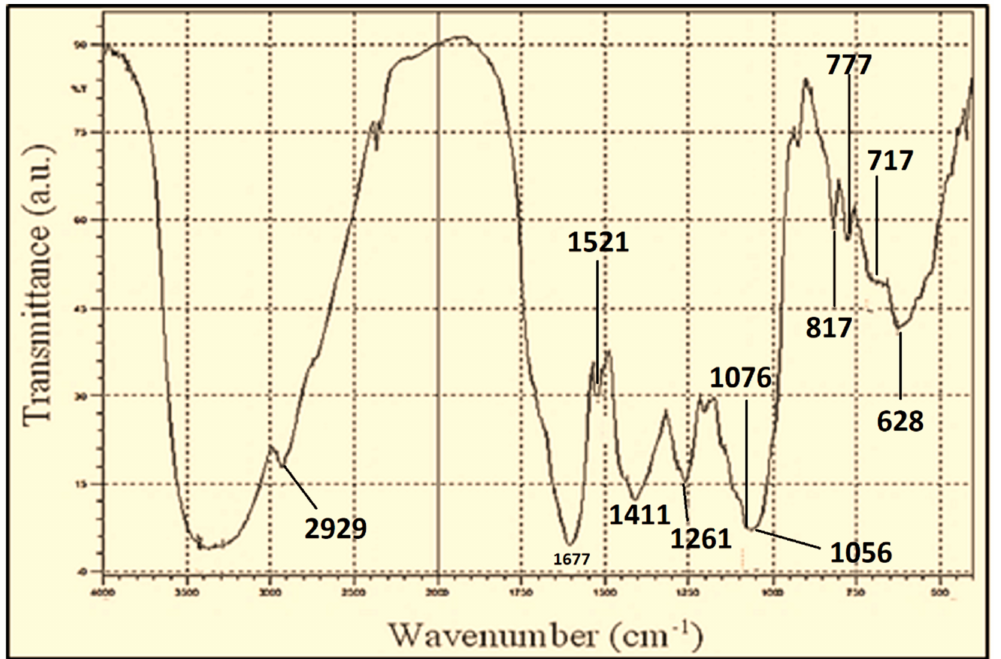
Figure 4. The FTIR spectrum of leaf extract of thyme